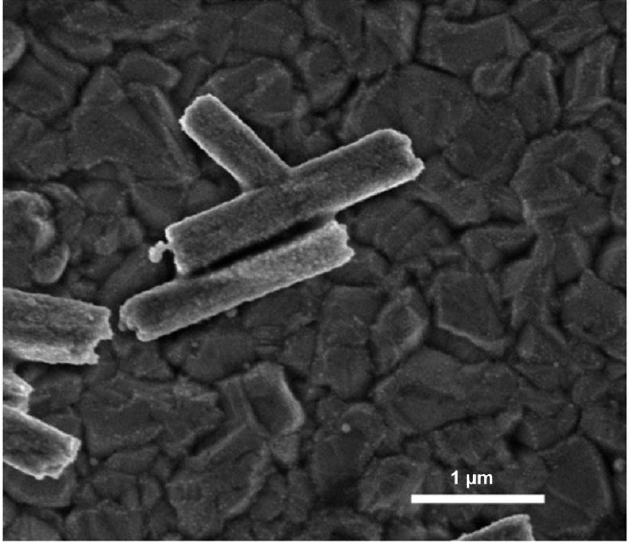
Figure 5. SEM image of ZnO microstructures synthesized by 25 mM equimolar mixture of Zn(NO ) and HMT at 100 °C for a period of 20 min. 3 2